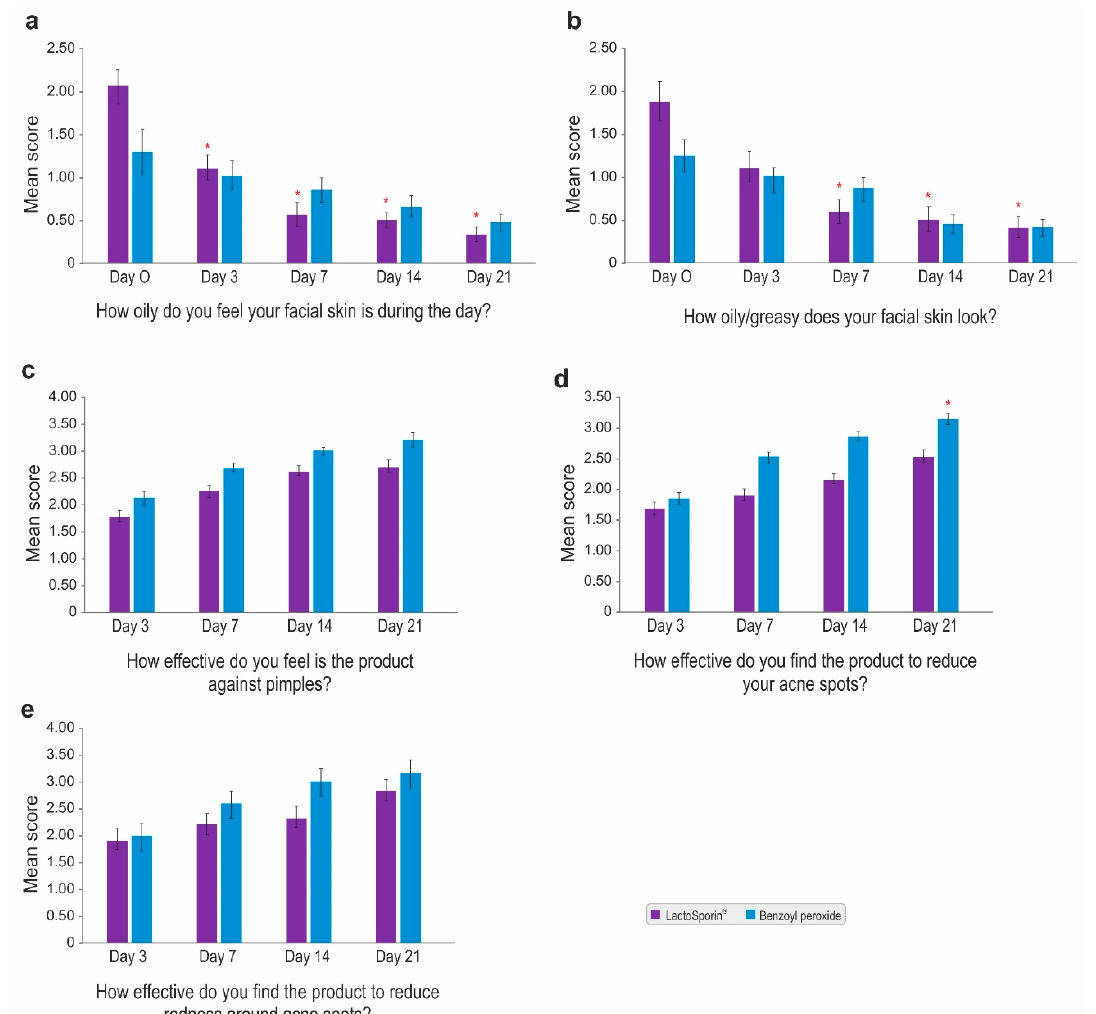
Figure 6. A self-Assessment questionnaire was given to subjects with five di ff erent questions to evaluate the improvement in the acne profile at day 0, day 3, day 7, day 14 and day 21. ( a ) How oily do you feel your facial skin is during the day? ( b ) How oily / greasy does your skin look? ( c ) How e ff ective do you feel is the product against pimples? ( d ) How e ff ective do you find the product to reduce your acne spots? ( e ) How e ff ective do you find the product to reduce redness around the acne spots? Values are expressed as mean ± SE, * p < 0.05 in comparison to benzoyl